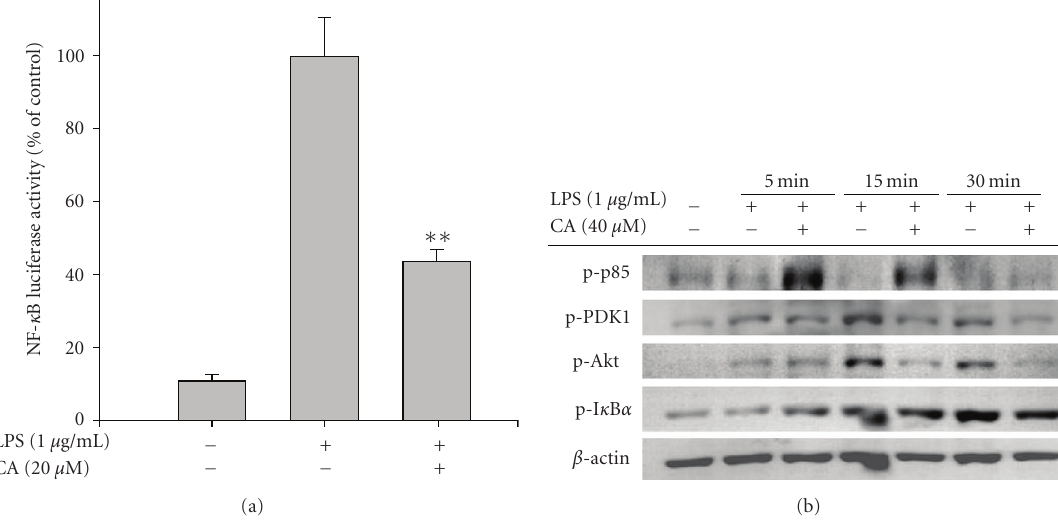
Figure 4: E ff ect of CA on the upstream signaling pathway for transcriptional activation of NF- κ B. (a) TLR-4-expressing HEK293 cells co- transfected with the plasmid construct, NF- κ B-Luc (1 κ g/ml), and β -gal (as a transfection control) were treated with CA in the presence or absence of LPS (1 μ g/ml) for 18 h, and luciferase activity was determined by luminometry. Data represents mean ± SEM of three independent observations performed in triplicate. (b) RAW264.7 cells (5 × 10 6 cells/ml) pretreated with CA for 1h were stimulated with LPS (1 κ g/ml) for indicated times. After immunoblotting, the levels of phosphorylated forms of p85, PDK1, Akt, and I κ B α were identified by corresponding antibodies. The data presented here is from one experiment, representative of three done in total. ∗∗ P < . 01 represents significant di ff erence compared to LPS